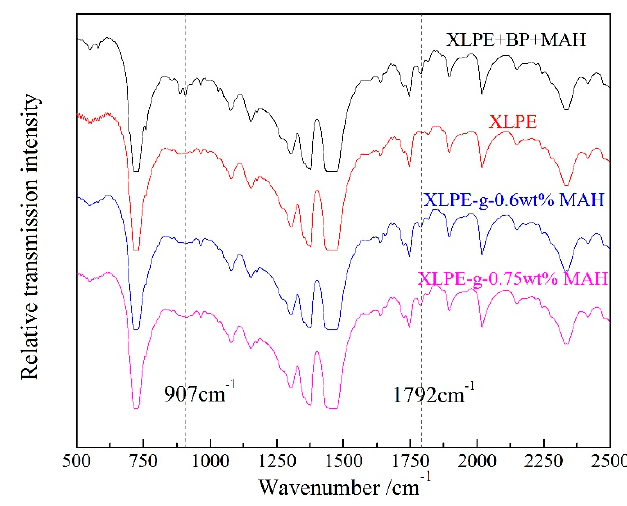
Figure 1. FT-IR transmission spectra of XLPE, XLPE + BP + MAH and XLPE-g-MAH for 0.6 wt % and 0.75 wt % grafting concentrations.